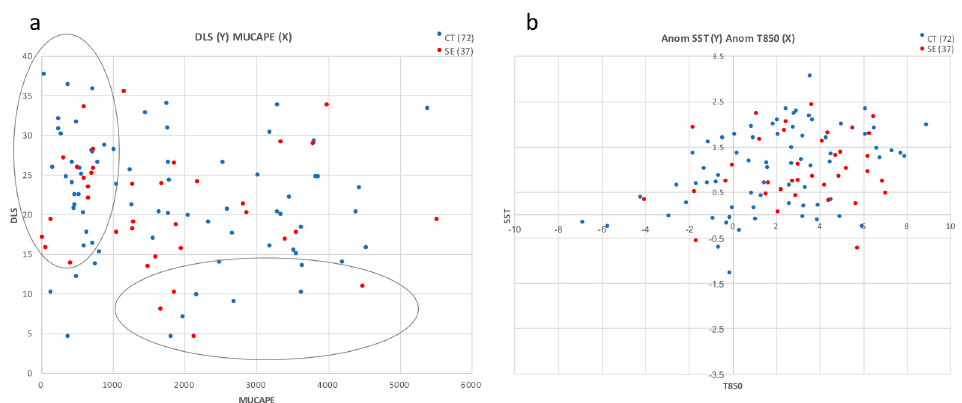
Figure 6. Scatter plots for the maximum daily values of: ( a ) MUCAPE [J kg − 1 ] (x-axis) and DLS [m s − 1 ] (y-axis) and ( b ) maximum daily anomaly values of T850 [K] (x-axis) and SST [K] (y-axis). Blue (red) dots refer to the CT − box (SE − box) maxima. The two ellipses on ( a ) help to individuate the HSLC/LSHC